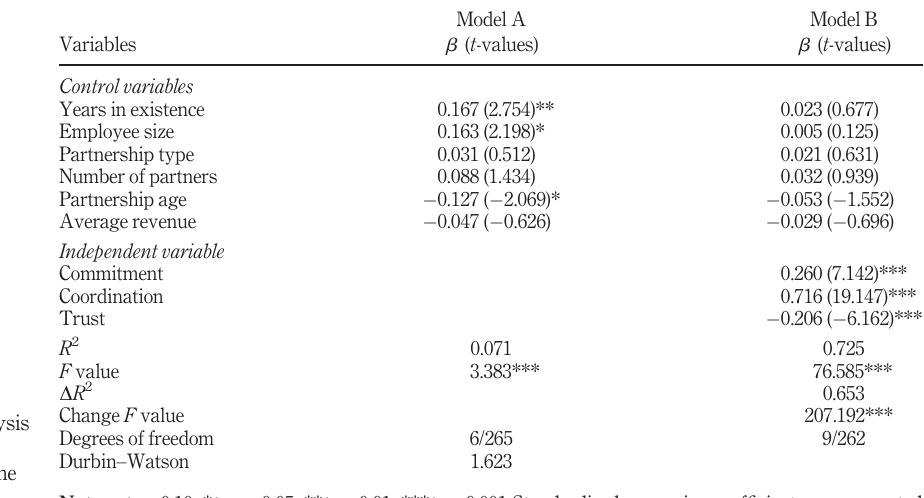
Table 5. Regression